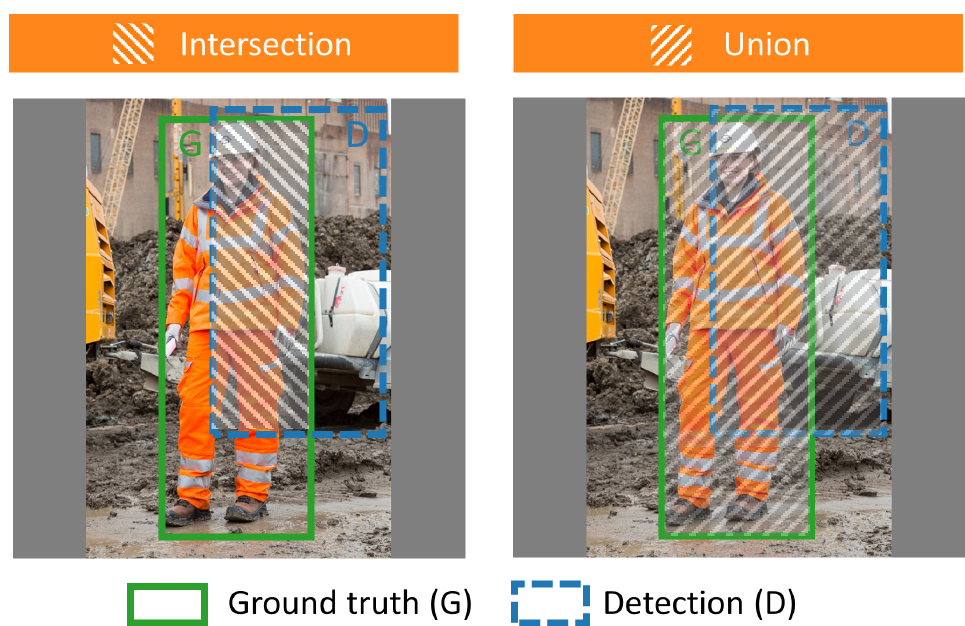
Figure 7. Examples of intersection and union. Precision represents the ability of a model to identify only the relative objects [40]. It is the percentage of correct positive predictions among all detections, as shown in Equation